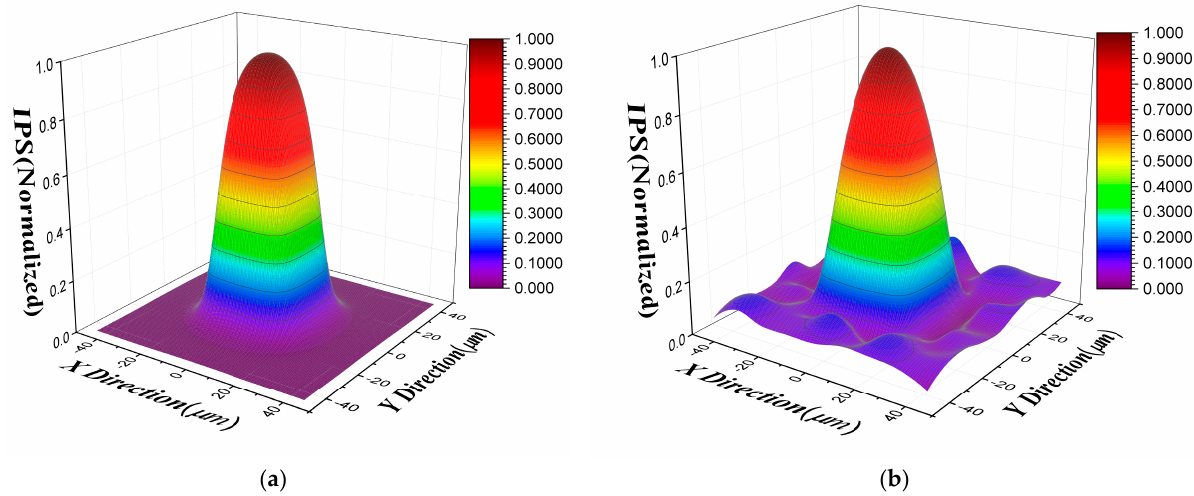
Figure 4. Calculated IPS for simulated data: ( a ) calculated IPS based on the DCP model; ( b ) calculated IPS based on the DSPR model.